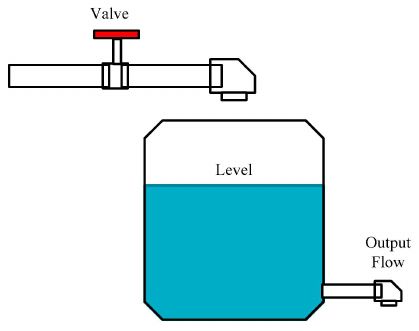
Figure 4. Water level tank